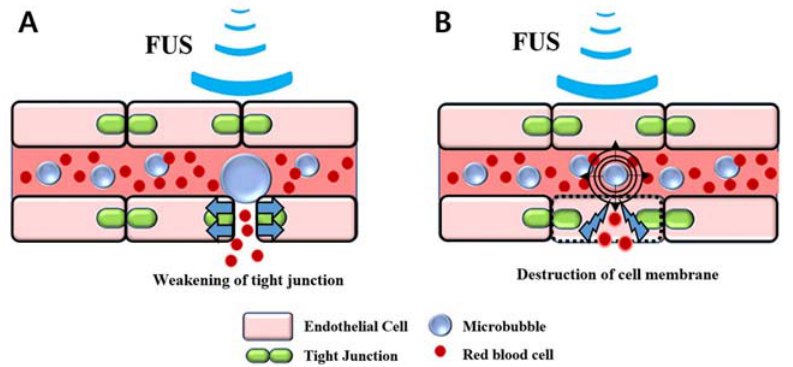
Figure 6. Illustration of the petechial hemorrhage caused by microbubble-assisted focused ultrasound (MB + FUS): ( A ) Blood–brain barrier disruption, ( B ) Destruction of cell membrane by microbubble-enhanced cavitation.